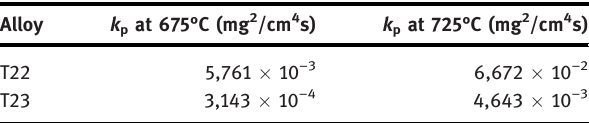
Table 2: k p values (mg 2 /cm 4 /s) for the exposed alloys at 657°C and 725°C for 500 h.